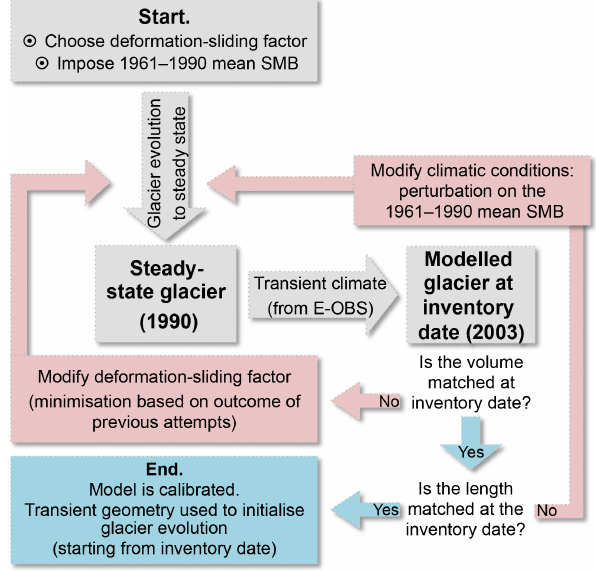
Figure 3. Model initialisation for creating a glacier with the refer- ence length and volume at the inventory